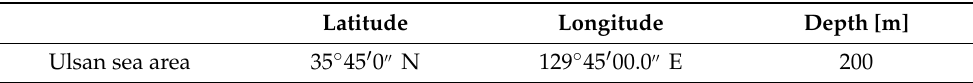
Table 3. Load case using ten ‐ year period extreme sea state case.